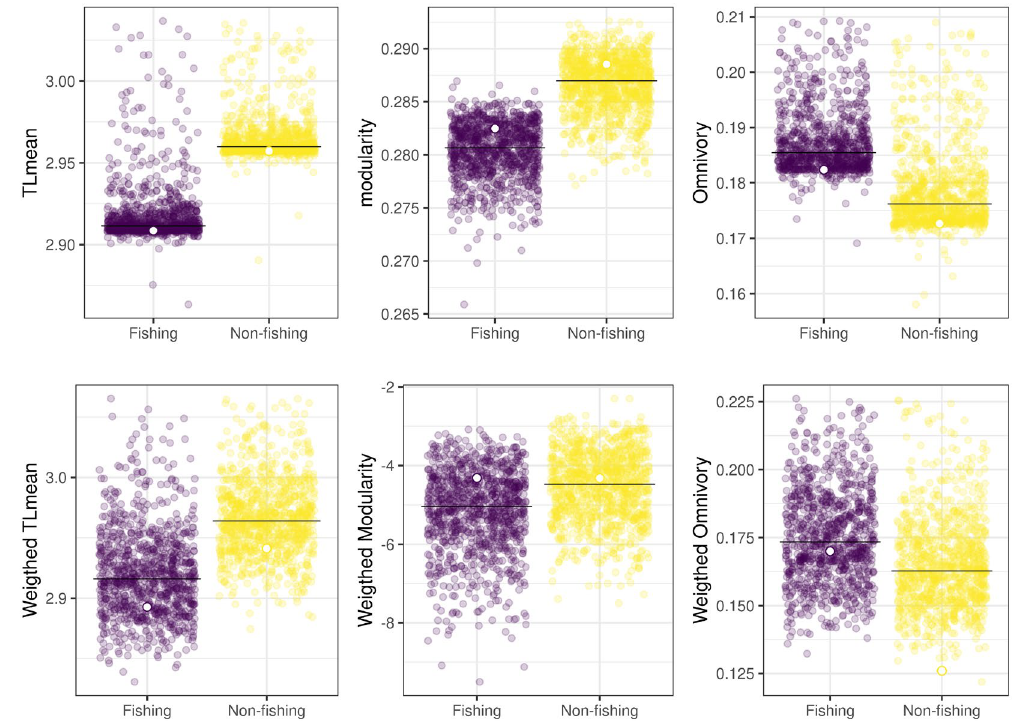
Figure 3. Comparison of the metrics for food-webs under fishing and non-fishing scenarios. The coloured points are randomizations of each food web keeping the number of links of each trophospecies constant, the weighted versions take into account the diets of the predators as link weight. The blank dots are the values of the empiric food webs, and the black lines the median of the randomized webs. Extreme values were eliminated from the plots for better visualization. These values were points below [Q1-(1.5)IQR] or above [Q3+(1.5)IQR], where Q1, Q3 are the first and third quantiles, and IQR is the interquartile range.